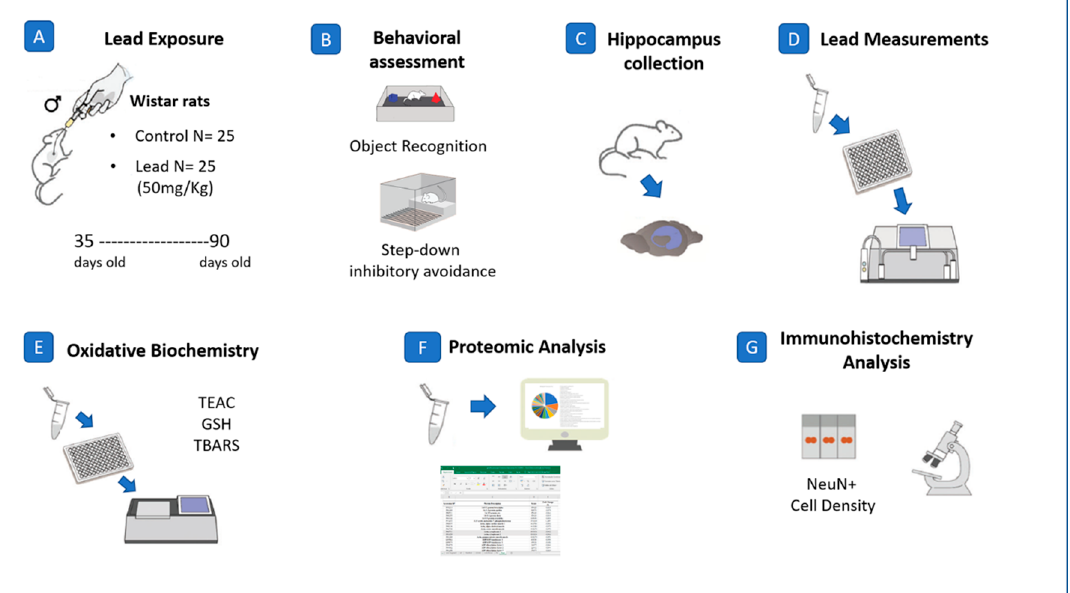
Figure 6. Methodological steps of this research. ( A ) description of the Pb exposure model and sample size; ( B ) behavioral tests elected for this investigation: object recognition test and step-down inhibitory avoidance test; ( C ) samples collection; ( D ) measurement of Pb levels; ( E ) analyses of oxidative biochemistry, through pro and antioxidant parameters; ( F ) proteomic profile performed by mass spectrometry; ( G ) immunohistochemical analysis for NeuN + cells density.